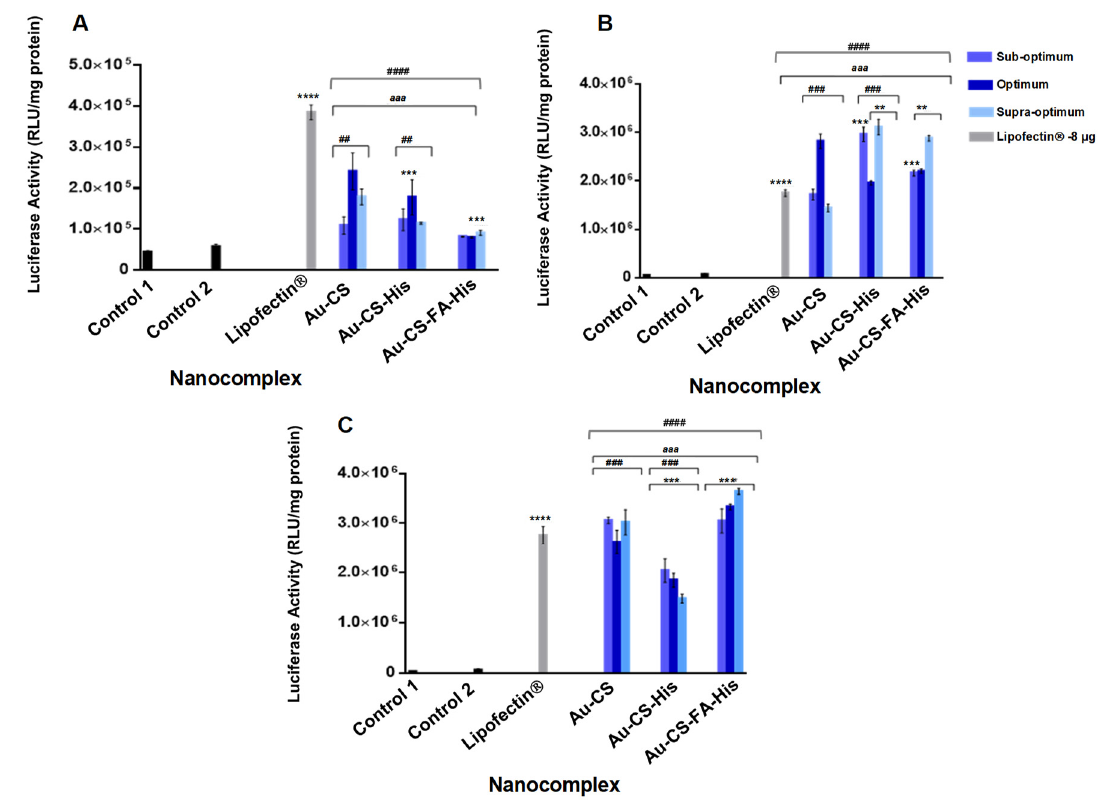
Figure 9. Luciferase activity in ( A ) HEK293, ( B ) SKBR3 and ( C ) MCF-7 cells. Data are represented as the mean ± SD ( n = 3). Control 1: untreated cells and Control 2: naked pDNA-treated cells. Lipofectin ® :pDNA complexes at the optimal gene expression were used as a positive control. ** p < 0.01 and *** p < 0.001 show statistical significance between the corresponding ratios of Au-CS-FA-His vs. Au-CS-His, **** p < 0.0001 vs. control 1, ## p < 0.01 and ### p < 0.001 show statistical significance between the corresponding ratios of Au-CS-His vs. Au-CS, aaa p < 0.001 shows statistical significance between the respective nanocomplexes vs. control 2 and #### p < 0.0001 shows statistical significance between FAuNPs vs. Lipofectin ® . The suboptimum, optimum and supraoptimum ratios are indicated in Table 2.